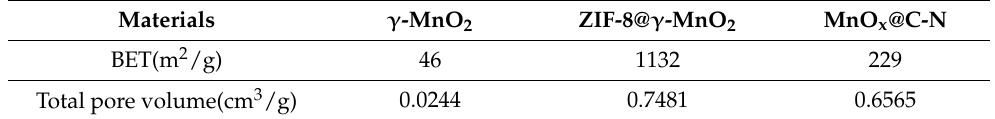
Table 1. BET and total pore volume of different materials. Materials